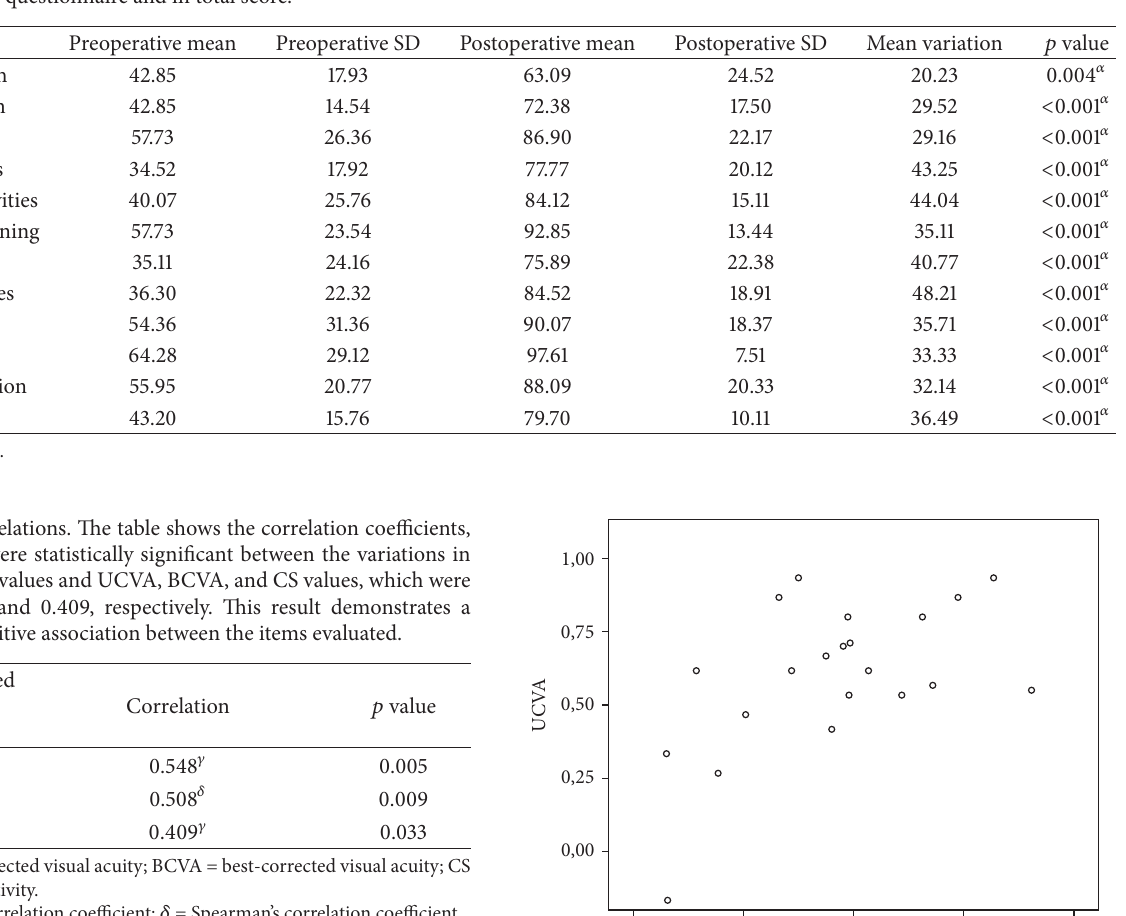
Table 4: Results of the NEI VFQ-25 showing positive variation with statistical significance between preoperative and postoperative values in all fields of the questionnaire and in total score.